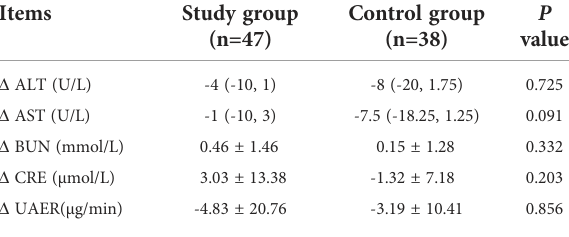
TABLE 4 Changes in Liver and kidney function